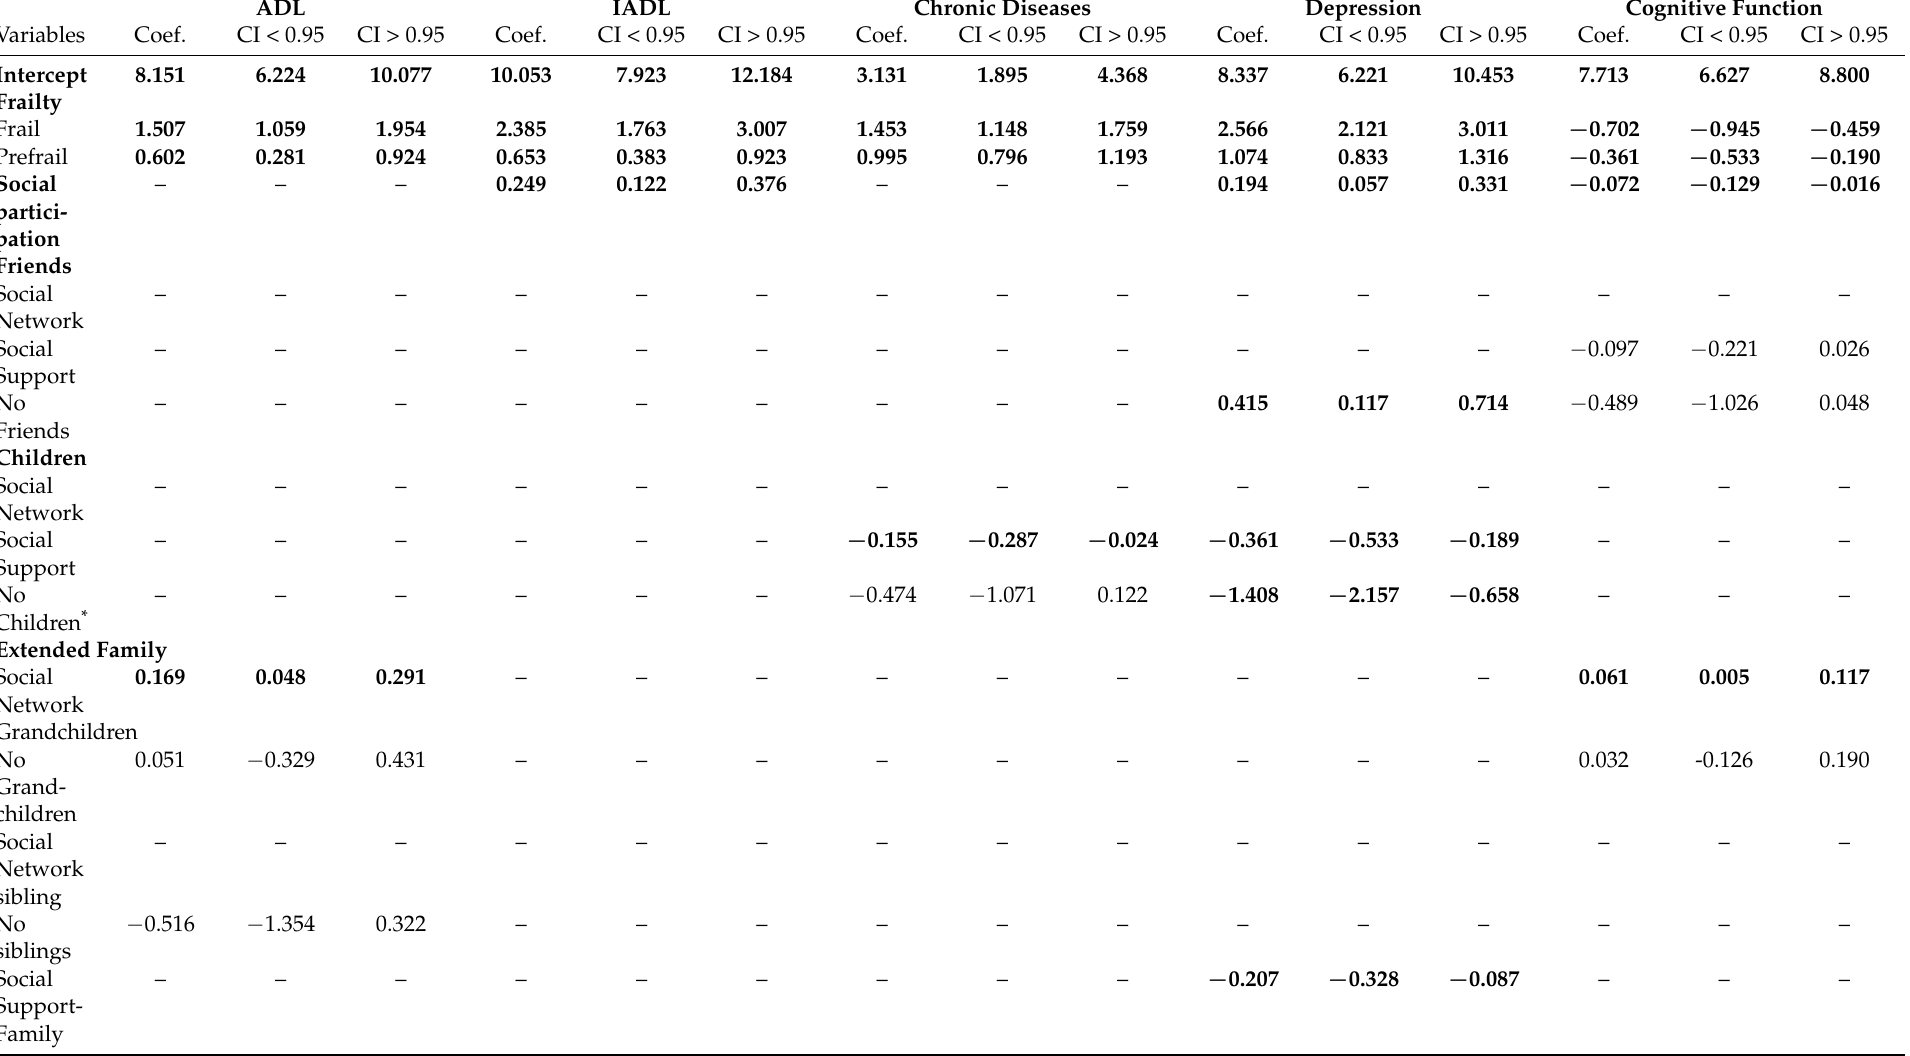
Table 4. Social isolation and frailty on health outcomes with interactions. IADL Chronic Diseases Depression Cognitive